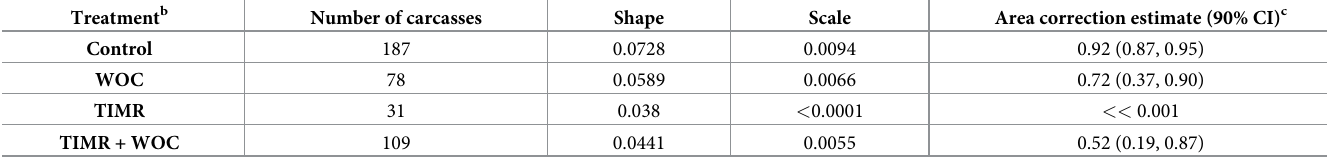
Table 2. Fitting details for the carcass density distribution models for the control treatment, wind-only curtailment treatment, Turbine Integrated Mortality Reduction treatment, and for combined wind-only curtailment treatment and Turbine Integrated Mortality Reduction treatment a . Treatment b